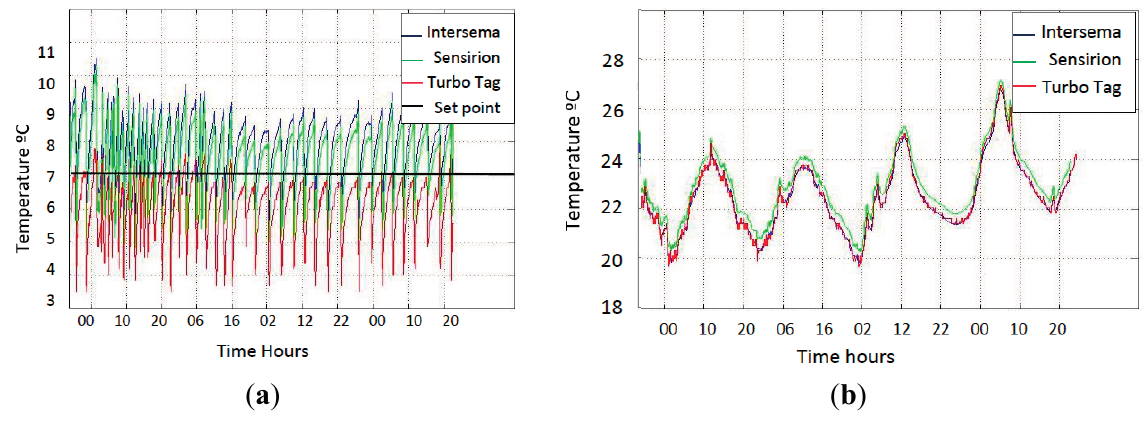
Figure 2. ( a ) Absolute temperature inside chamber 29; ( b ) Absolute temperature pre-chamber